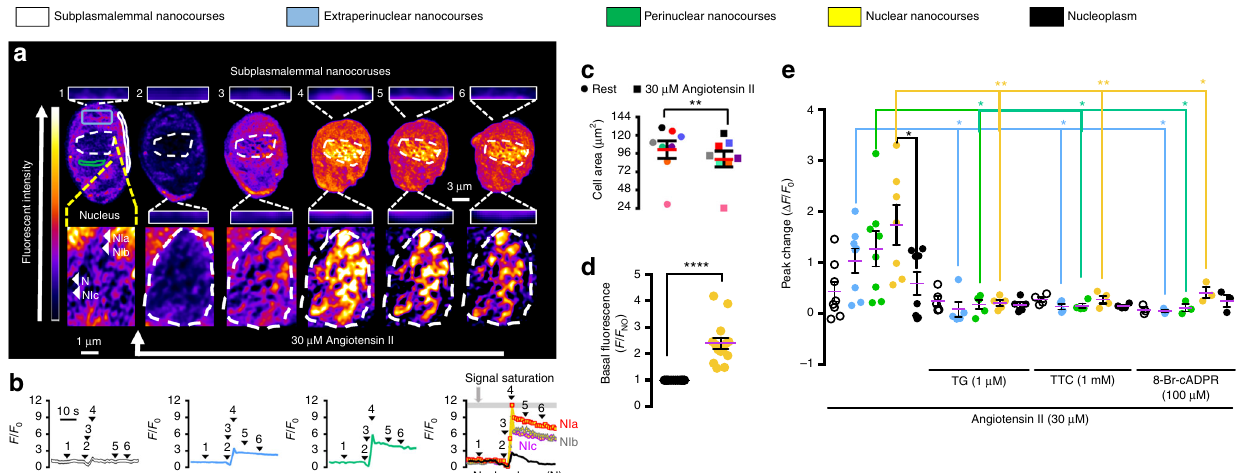
Fig. 6 Angiotensin II induces myocyte contraction by directing propagating Ca 2 + signals through nanocourses. a (upper panels), Time series of deconvolved z sections shows pseudocolour representations of Fluo-4 fl uorescence intensity in an arterial myocyte (white broken line indicates nucleus) during Angiotensin II application (30 µ M, white arrow). Insets above and below image show example subplasmalemmal nanocourses at higher magni fi cation. Lower panels as in upper panels but showing changes in Fluo-4 fl uorescence intensity within nuclear nanocourses (white arrows indicate: nucleoplasm, N; Nuclear nanocourses, NI1, NI2 and NI3). Note, with cell-wide acquisition of Angiotensin II responses, signal saturation (grey bar) in some nuclear nanocourses was unavoidable (excluded from quantitative analysis). b Fluo-4 fl uorescence ratio ( F x / F 0 ; where F 0 = fl uorescene at time 0 and F x = fl uorescence at time = x) versus time (sampling frequency 0.5 Hz) for a subplasmalemmal nanocourse (white), regions of interest within